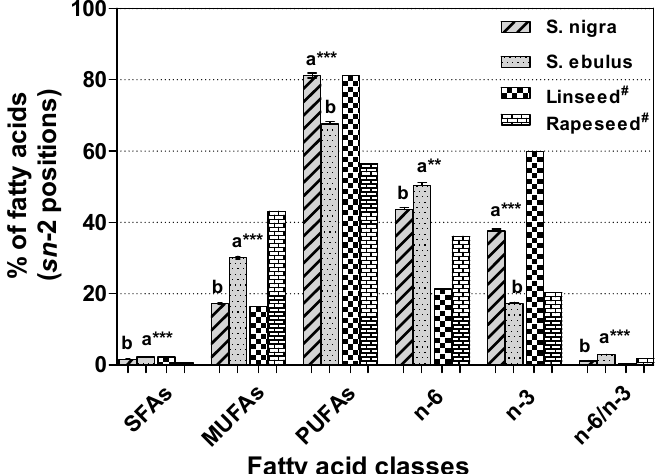
Figure 3. The percentage composition (means ± standard deviation, n = 3 × 3) of fatty acid classes in the TAGs sn -2 position of Sambucus seed, linseed and rapeseed